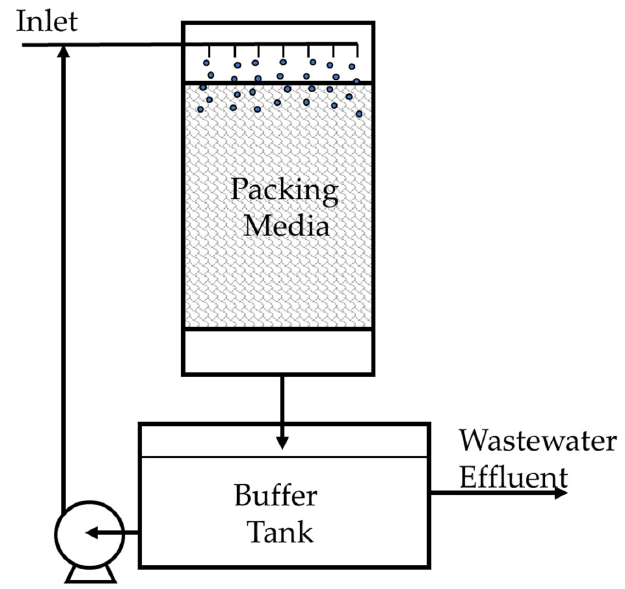
Figure 6. Schematic of the trickling fi lter